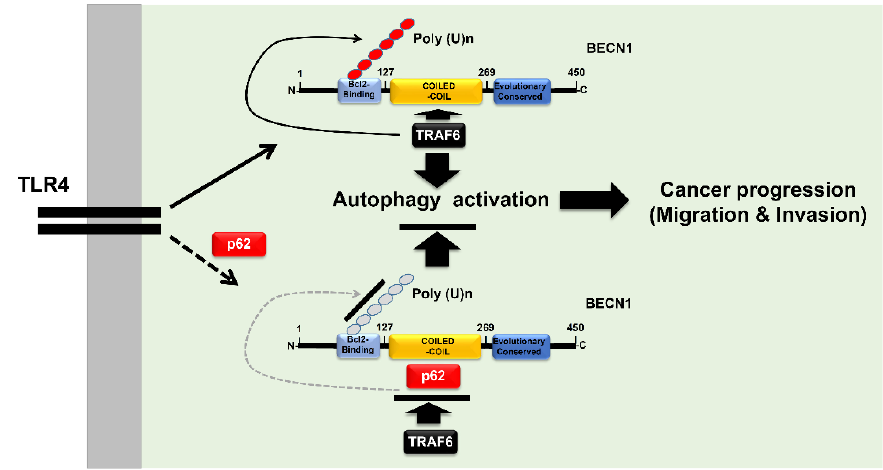
Figure 7. p62 is negatively involved in autophagy activation, and cancer cell migration and invasion in response to TLR4 stimulation. Engagement of TLR4 ligand leads to the association of TRAF6-BECN1 complex, and that induces the ubiquitination of BECN1. BECN1 ubiquitination induces the activation of autophagy, thereby potentially regulating cancer progression, via migration and invasion, as depicted in the upper panel. However, the interaction between p62 and BECN1 inhibits the association of TRAF6 to BECN1, and that inhibits the ubiquitination of BECN1, leading to inhibitions of autophagy activation, and cancer cell migration and invasion, as depicted in the lower panel. Figure S1: TRAF6 interacts with p62.; Figure S2: Generations of TRAF6 or BECN1 truncated mutants.; Figure S3: Figure S5: The association between SQSTM1 / p62 expression and primary tumors.; Figure S6: The association between SQSTM1 / p62 expression and tumor